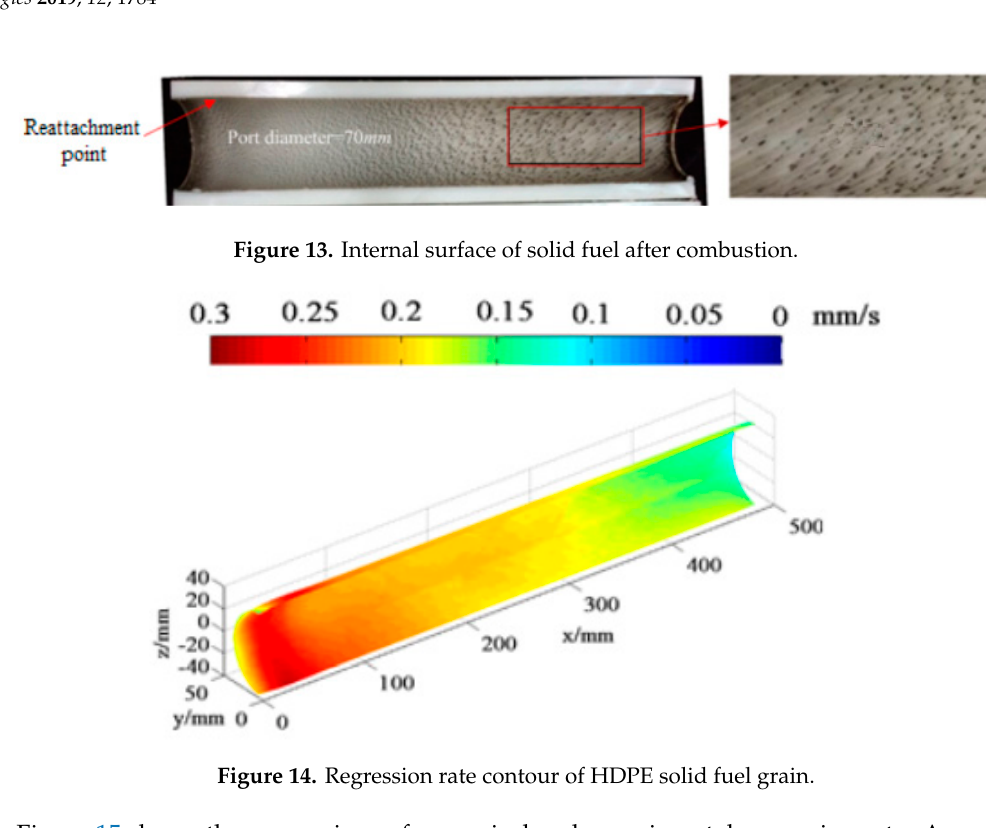
Figure 14. Regression rate contour of HDPE solid fuel grain.